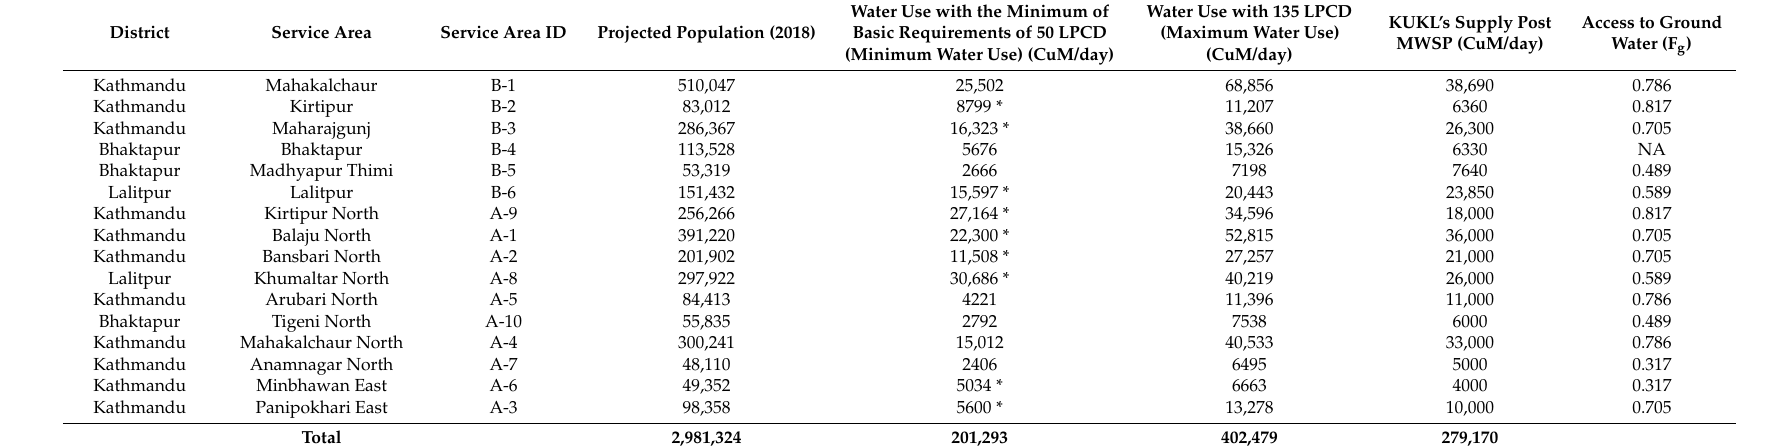
Note: * Service areas with minimum water use > 50 LPCD because current water use > 50